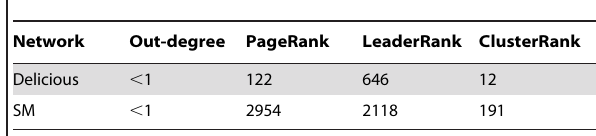
Table 2. The CPU time (in seconds) of out-degree centrality, PageRank, LeaderRank and ClusterRank for Delicious and SM networks in a single run.